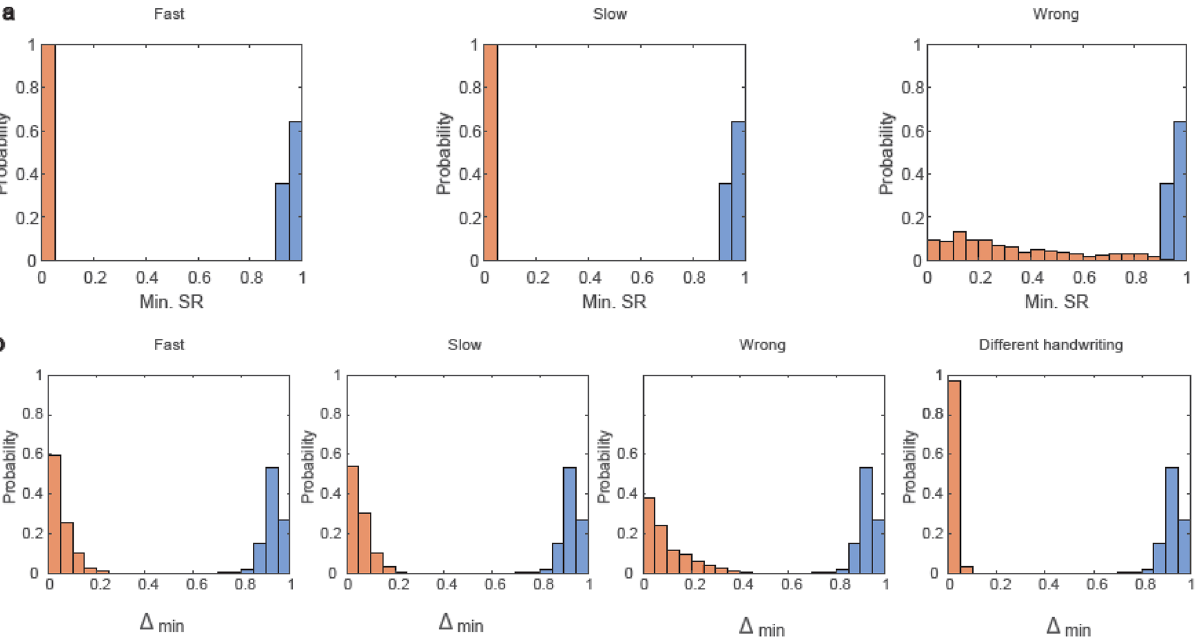
Figure 4. Generalization of the brain-inspired SFNNs to ANNs. ( a) Fully-connected ID-net (Fig. 1b), but with sigmoid activation functions for the units (“Methods”), which is trained on a dataset that is similar to Fig. 2a (“Methods”). The blue and orange histograms, averaged over 720 instances, are constructed similarly to Fig. 2a for the three types of imperfect test sequences: fast/slow/wrong. The overlap between the blue and the orange histograms in the wrong panel is 0.56% for threshold 0.9 and zero for the other two panels. ( b ) Similar to Fig. 3, where the LeNet-5 architecture with ReLU activation function is trained on one individual’s handwriting, comprising a sequence of 10 different CIFAR-10 objects with 50 additional similar synthetic sequences (“Methods”). The panels represent the four imperfections: fast, slow, wrong, handwriting of different individuals, similar to Fig. 3a–d. The overlap between the orange and blue histograms vanishes for threshold 0.69, where each histogram was averaged over 720 instances comprising 20 samples